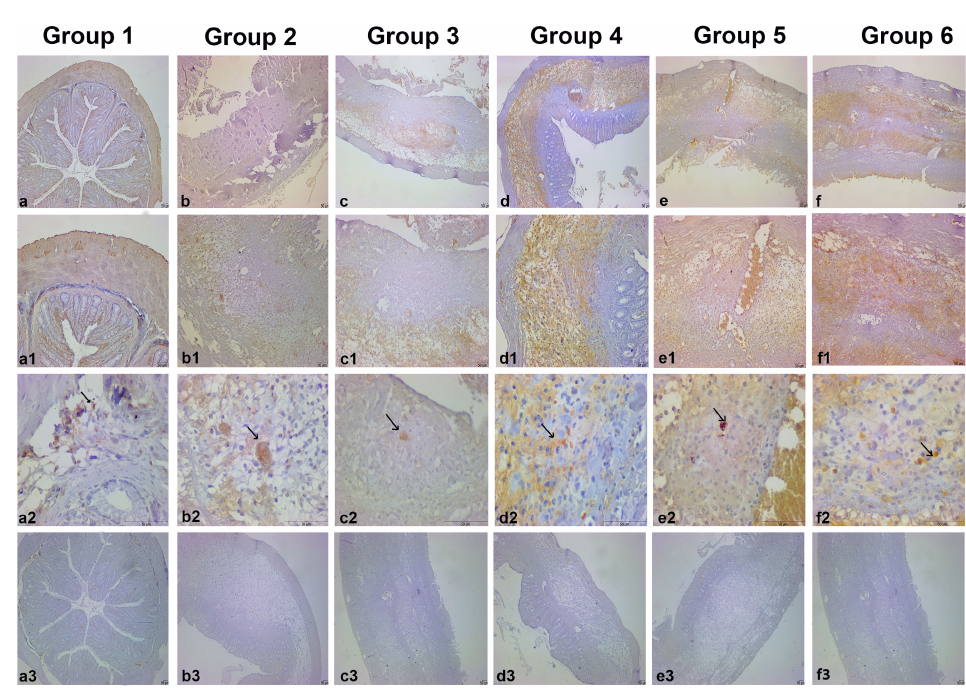
Figure 3. Mast cell tyrptase immunohistochemistry in colon descendens of experimental groups. Scale bars: 50 µm. (a-f) 40 × , (a1-f1) 100 × , (a2-f2) 400 × magnification. (a3-f3) 40 × magnification and show isotype controls. Black arrows show mast